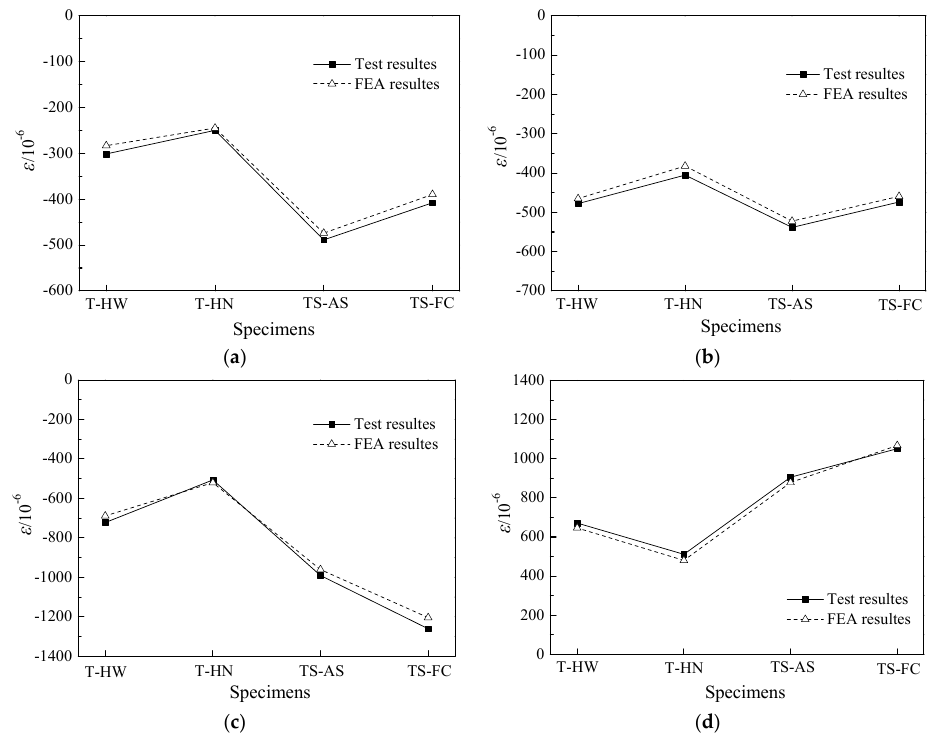
Figure 17. Comparison of experimental and finite element analysis axial strains. ( a ) Top chord ‘hj’; ( b )Top chord ‘fh’; ( c ) Diagonal brace ‘jp’; ( d ) Diagonal brace ‘jo’.